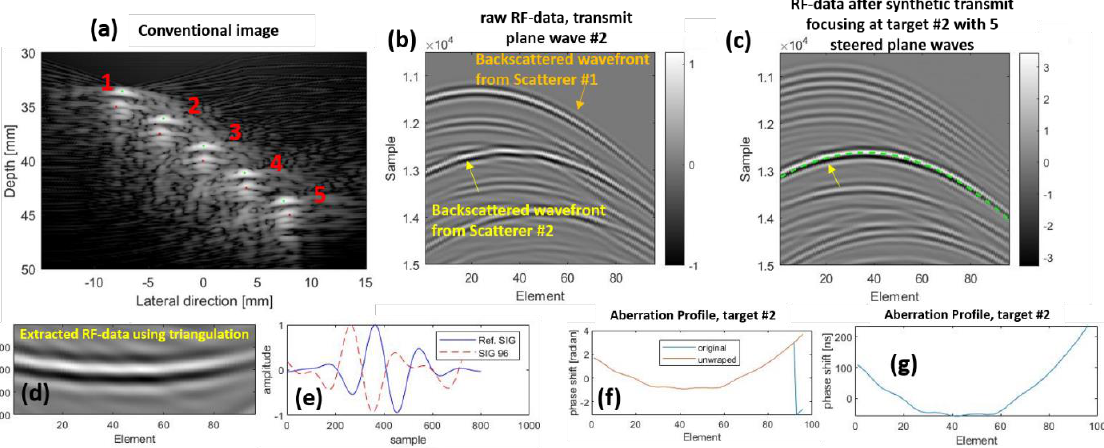
Figure 2. ( a ) The reconstructed image using the conventional delay-and-sum beamformer; the aberrator model and phantom shown in Figure 3a,c were used to generate the numerical RF data. ( b ) The numerical wavefront backscattered from scatterer #2 for a tilted (by 7.5 degrees in cutaneous tissue) transmit plane wave. ( c ) The numerical wavefront after synthetic transmit focusing at the location of scatterer #2 by coherent compounding of the RF data obtained with 5 tilted plane waves (from − 15 to 15 degree in cutaneous tissue). ( d ) The extracted wavefront using triangulation assuming a uniform medium. ( e ) The reference signal and the A-line received by element 96 of the array. ( f ) The estimated phase shifted and its unwrapped version for each element. ( g ) The estimated phase shift (aberration profile) in nanoseconds for the isoplanatic patch around target #2. The red and green dots in ( a ) indicate the true location of the scatterers and the brightest pixel in the conventional image that is actually used to apply the PS method, respectively. The red numbers in (a) are used for referencing in the text.